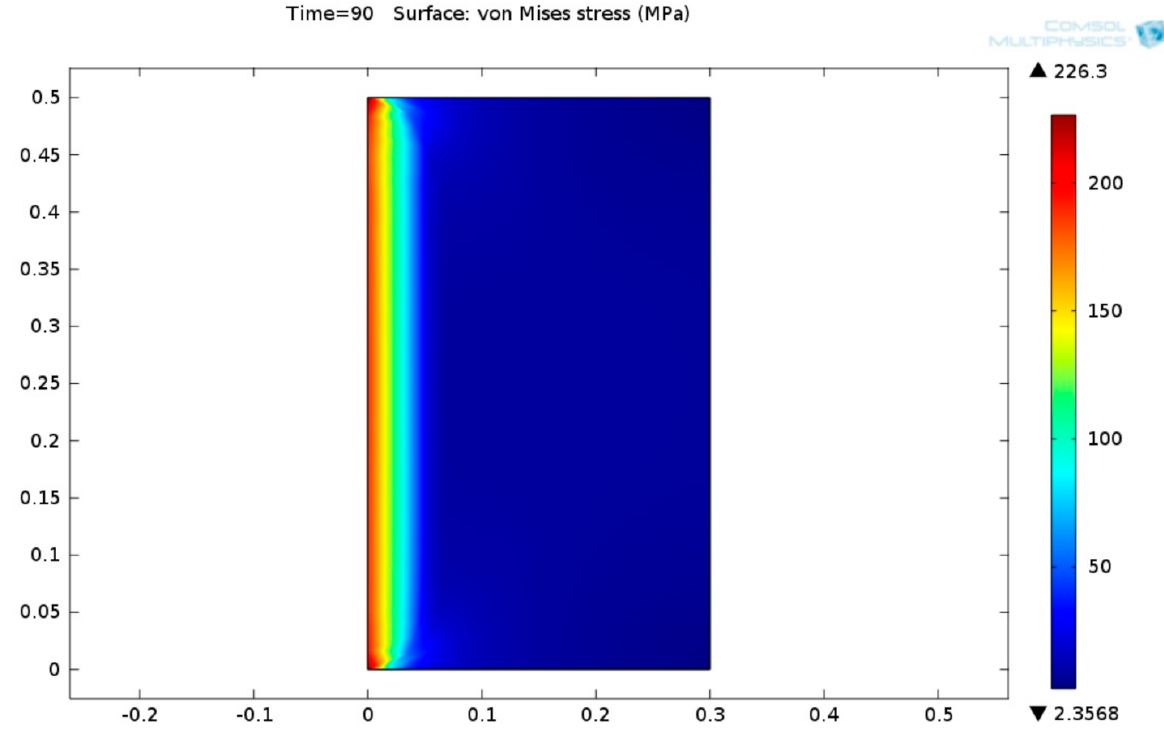
Figure 18. 2D plot of the fiber-reinforced carbonate aggregate concrete von Mises stress